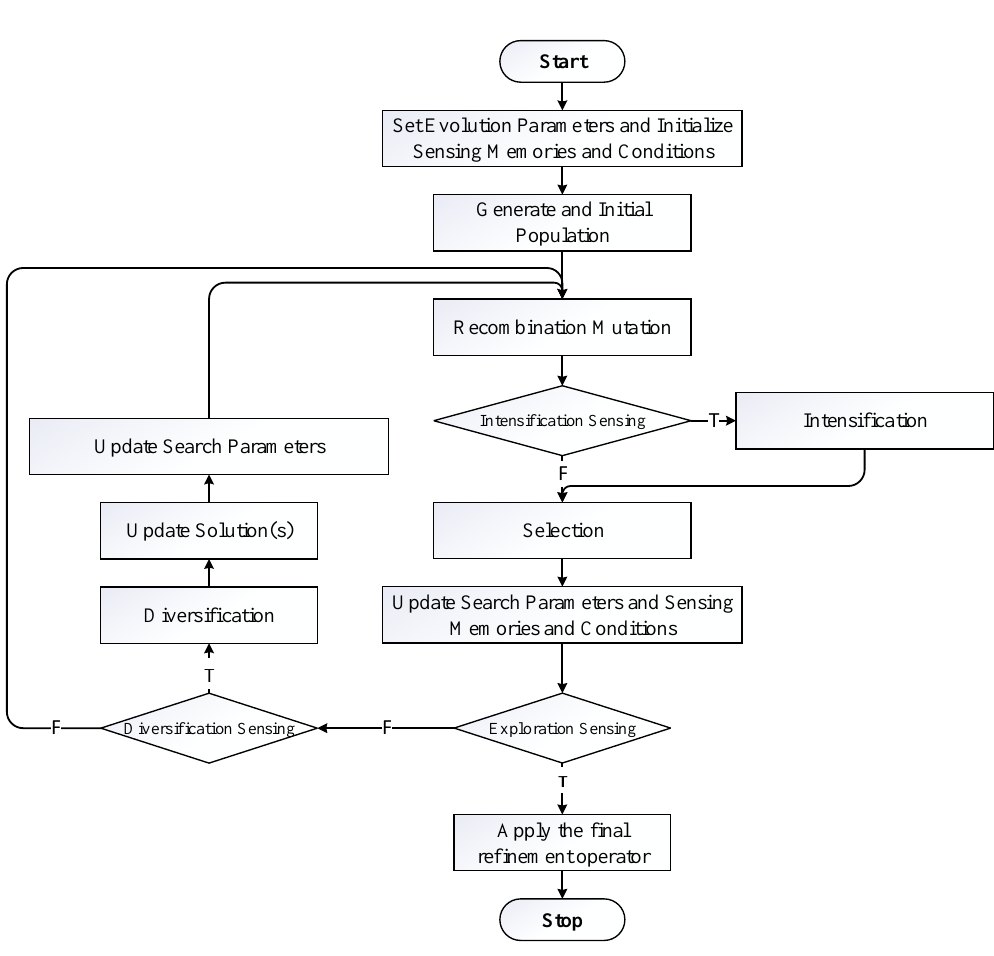
Figure 4. A flowchart for the Sensing Evolution Strategies with Quadratic Search (SESQS).